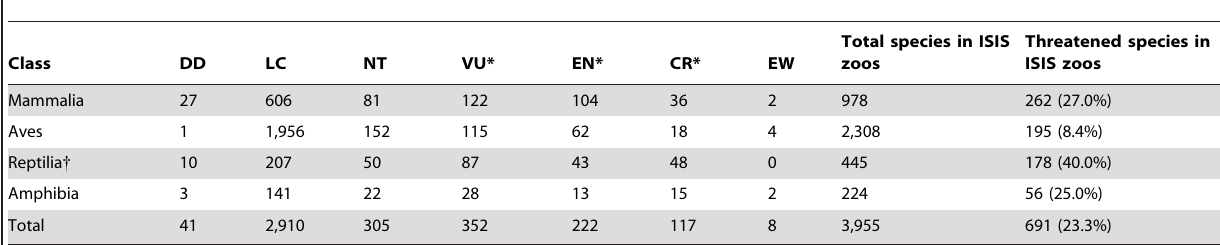
Table 2. Number of species of terrestrial vertebrates held in ISIS zoos broken down by IUCN Red List